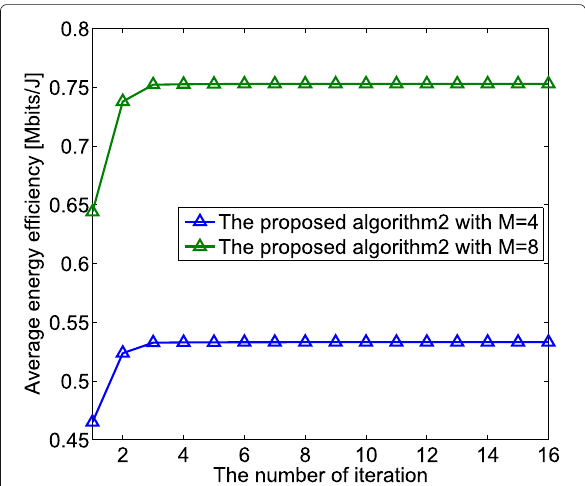
gain in NOMA systems is superior to OMA from the perspective of energy efficiency.